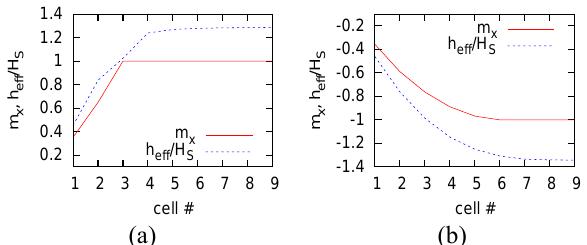
Figure 10: Distribution of m x and h eff in the direct solution method with 128 cells: (a) h = 0 and (b) h = 